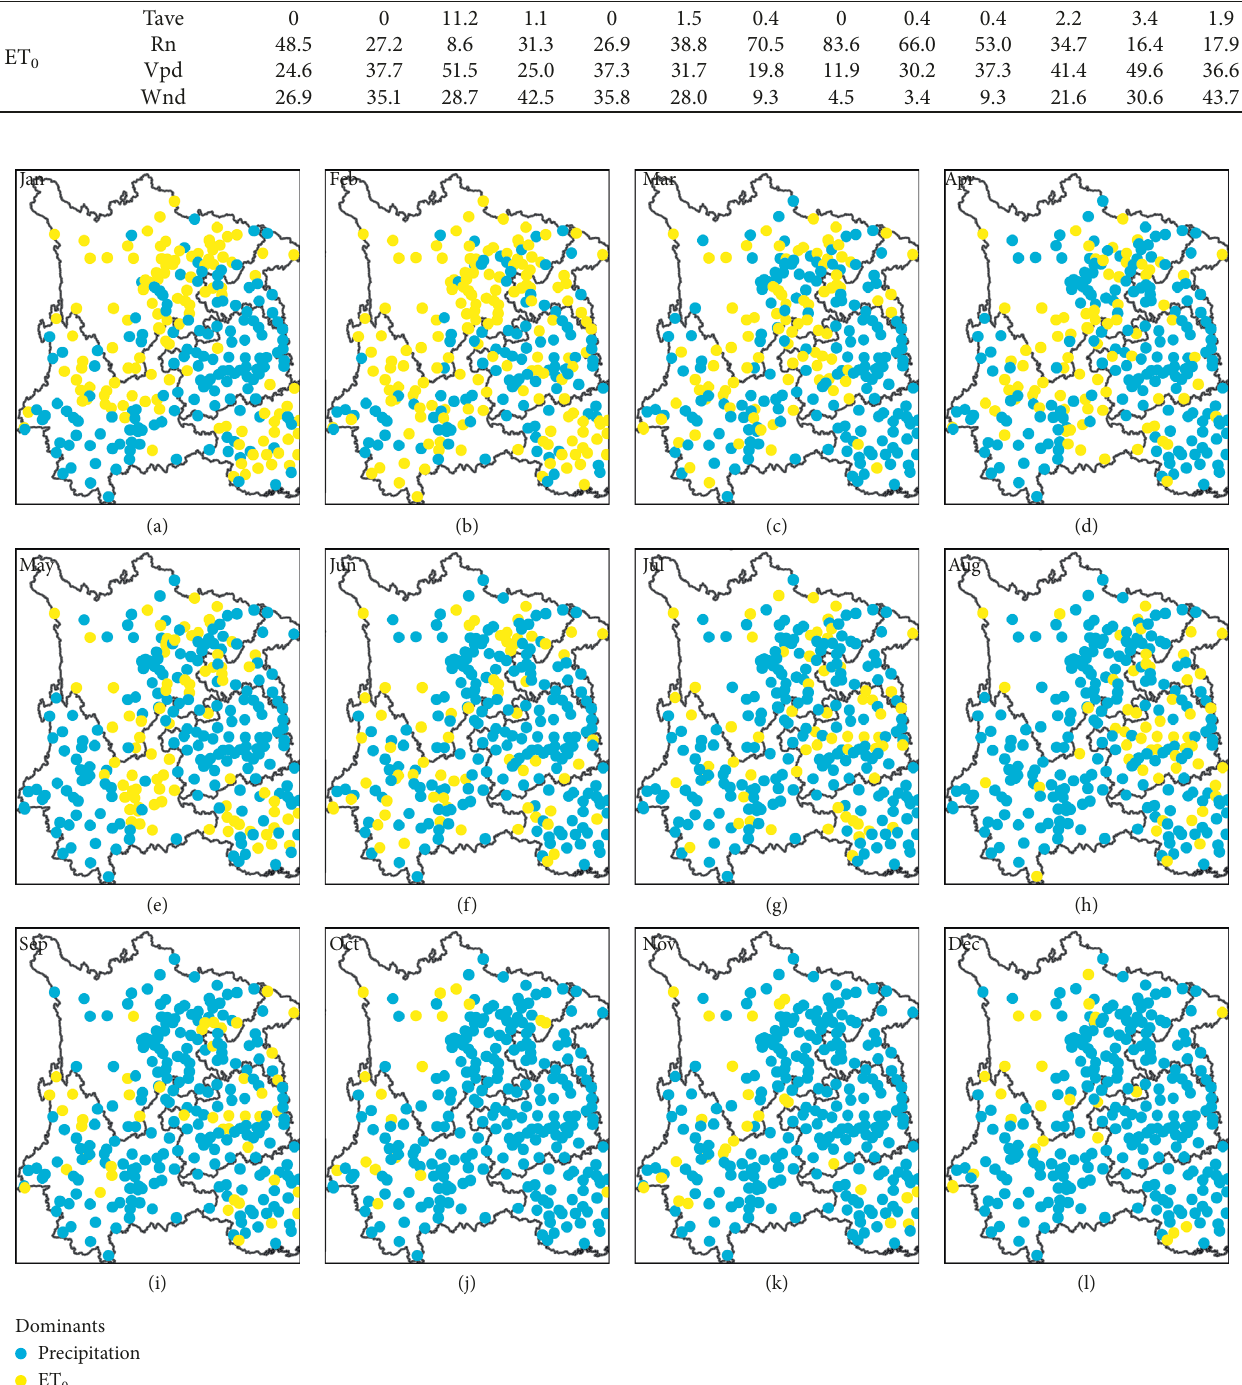
Figure 6: Spatial patterns of dominants of monthly SPEI-3 changes during 1961–2012.